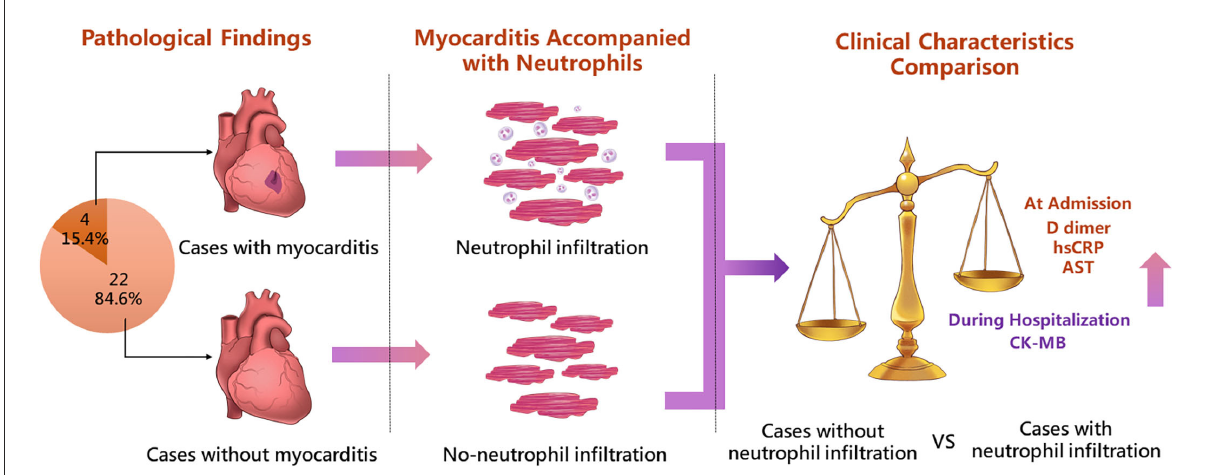
FIGURE3 Highlight overview. The figure shows the highlight overview of the present autopsy cohort study. Neutrophil infiltration in heart tissue was associated with active pathological myocarditis in COVID-19. Patients with neutrophil infiltration had dramatically elevated levels of both